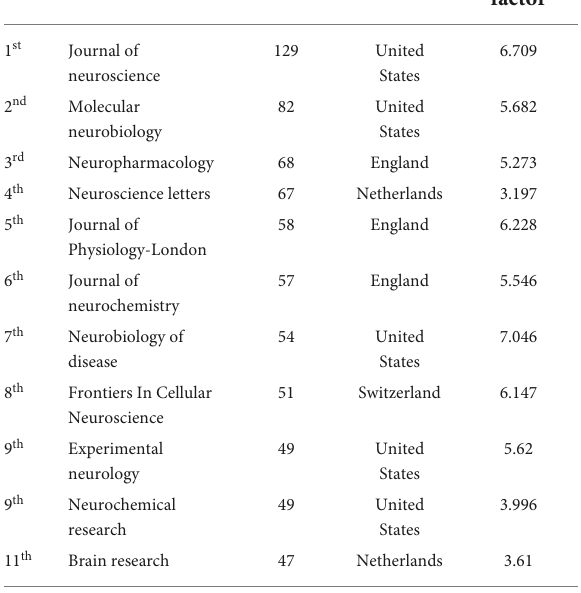
TABLE 4 Core authors of publications of mTOR in the field of neuroscience from 2002 to